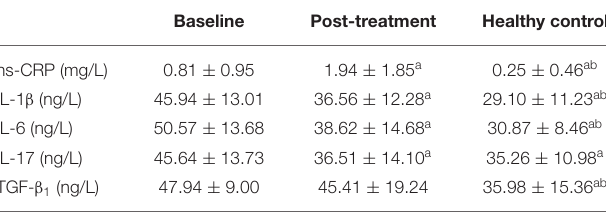
TABLE 3 | Changes of five inflammatory factors before and after treatment. Baseline Post-treatment Healthy